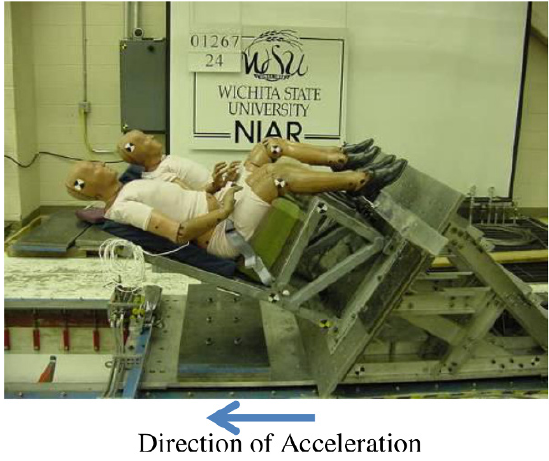
Figure 9. Full-scale dynamic sled test for certification of seat cush- ions.